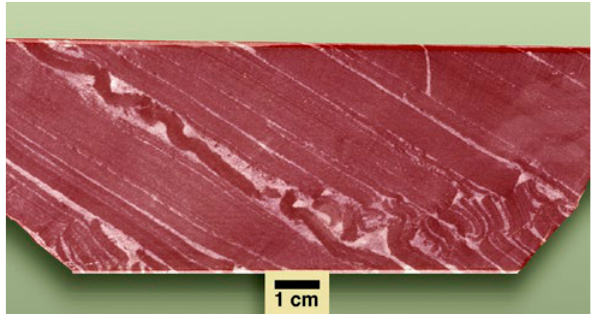
Figure 32. Laminose flow or lateral slippage along overpressured fluid-rich bedding planes during diagenesis has allowed some of the hematite shale bands to fold and disrupt. The suspending ‘fluid’ was probably filled initially with dilute polymeric silica as a “dirty early quartz vein” and then ‘infilled with additional Si(OH) 4 to crystallise as whiter quartz. (From Gecko Mine drill core, Tennant Creek, NT.).